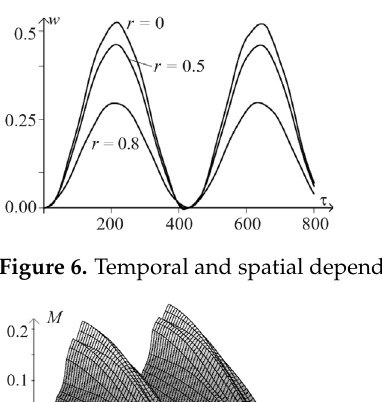
Figure 5. Spatio-temporal dependencies for deflection w ( r , τ ) .